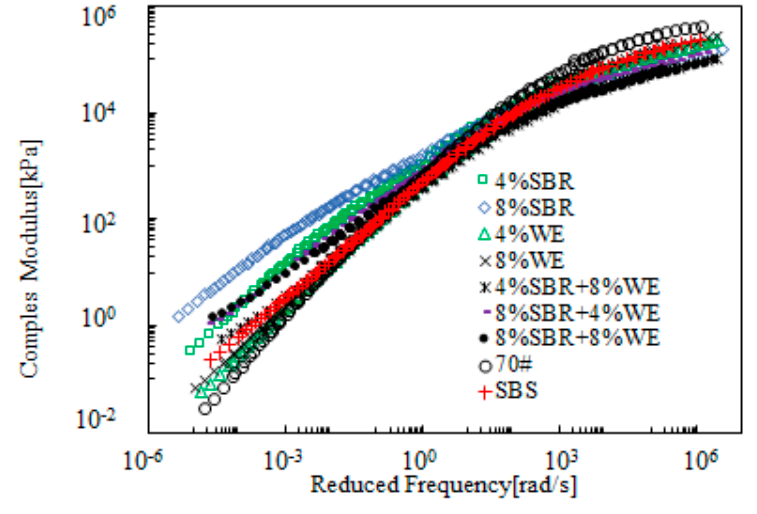
Materials 2019 , 12 , x FOR PEER REVIEW Figure 13. Master curves of complex modulus of SBR + WE-modified bitumen emulsion.